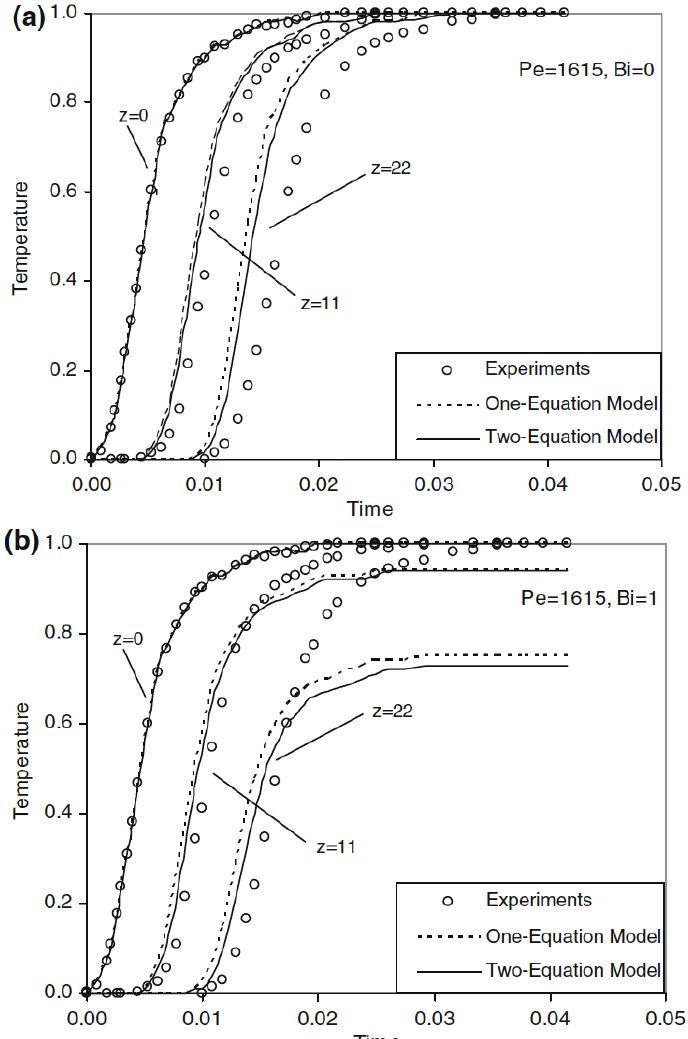
Figure 19. Local temperature profiles from experiments compared with numerical results from one-equation and two-equation models, for glass-water bed at ( a ) Bi = 0, and ( b ) Bi = 1.0, reported by Singh et al.